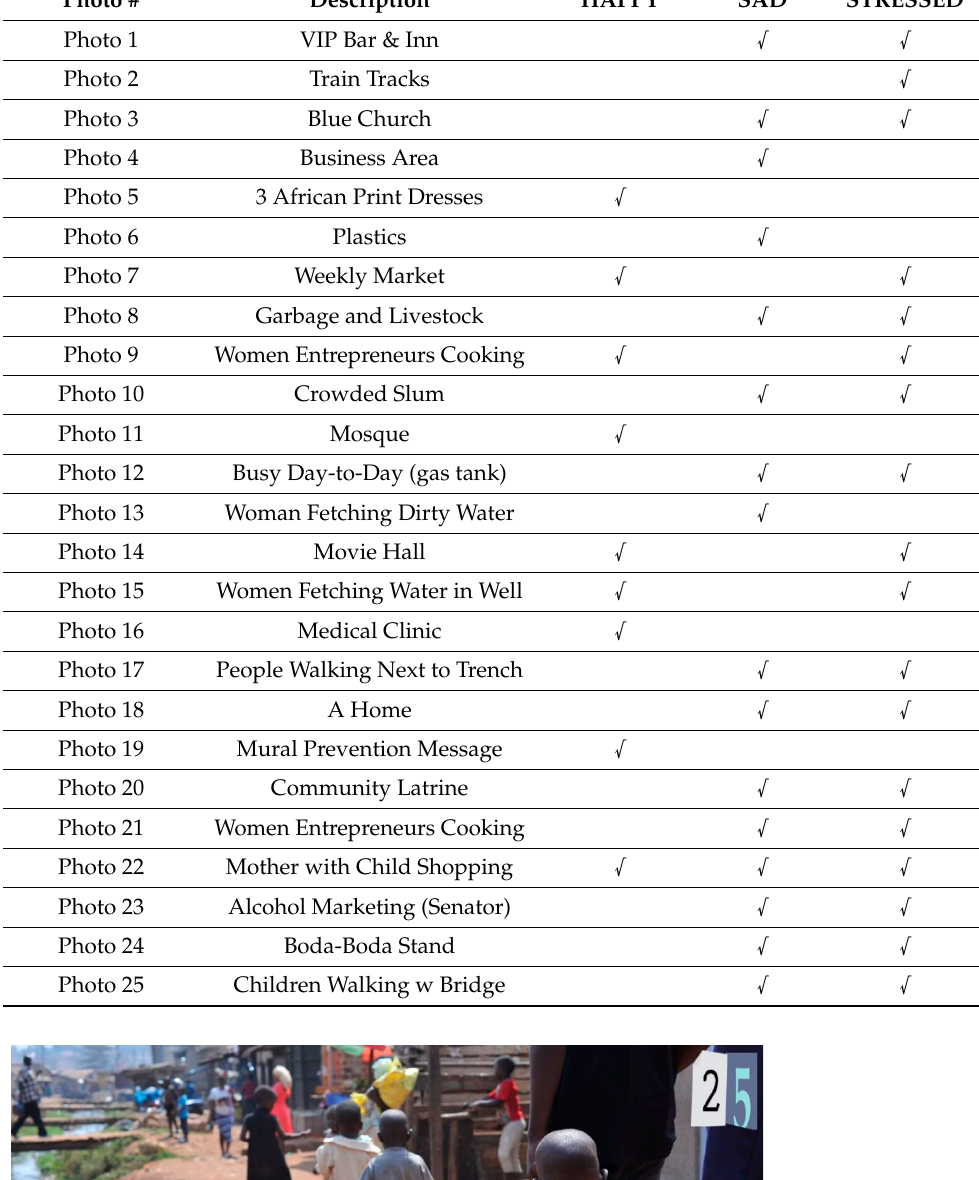
Table 1. Participants’ Group Response to 25 Photos of Places within Urban Slums that are Linked to Mental Health and Elicit an Emotional Response.